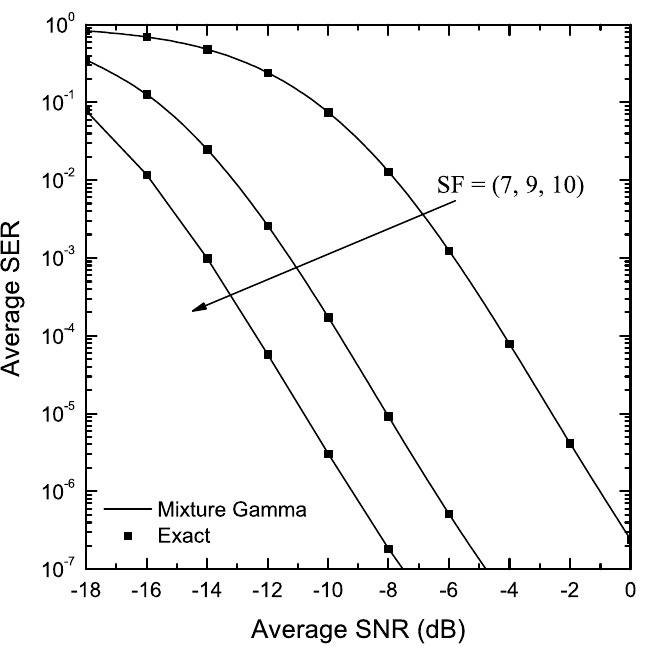
Figure 10. SER of LoRa systems operating in the presence of κ - µ fading as a function of the SNR, γ , for κ = 10, µ = 2.1 and various values of